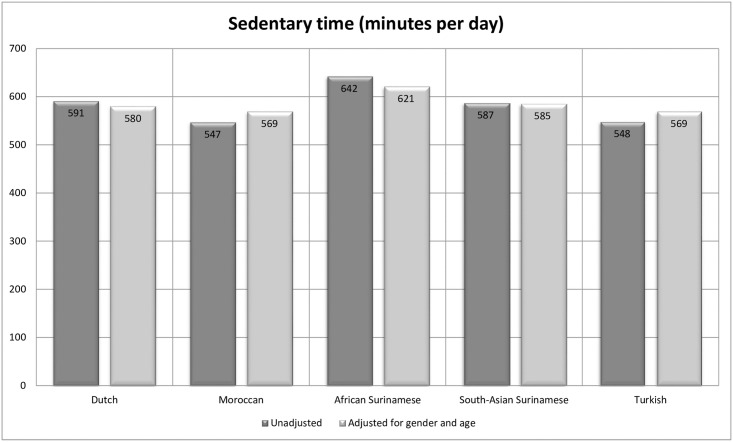
Mean sedentary time (minutes per day) among the different ethnic groups, unadjusted (dark grey) and adjusted for gender and age (light grey).